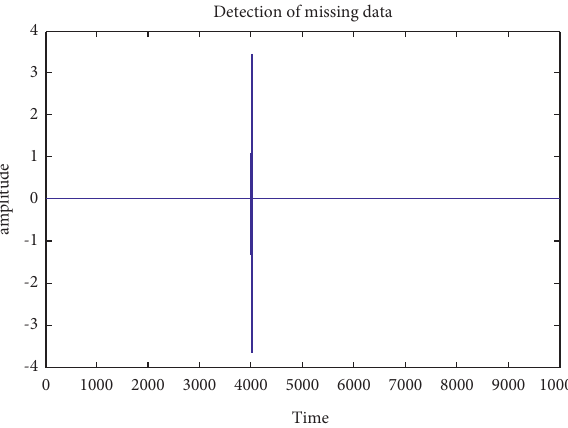
Figure 3: Detection waveform of the sample data.